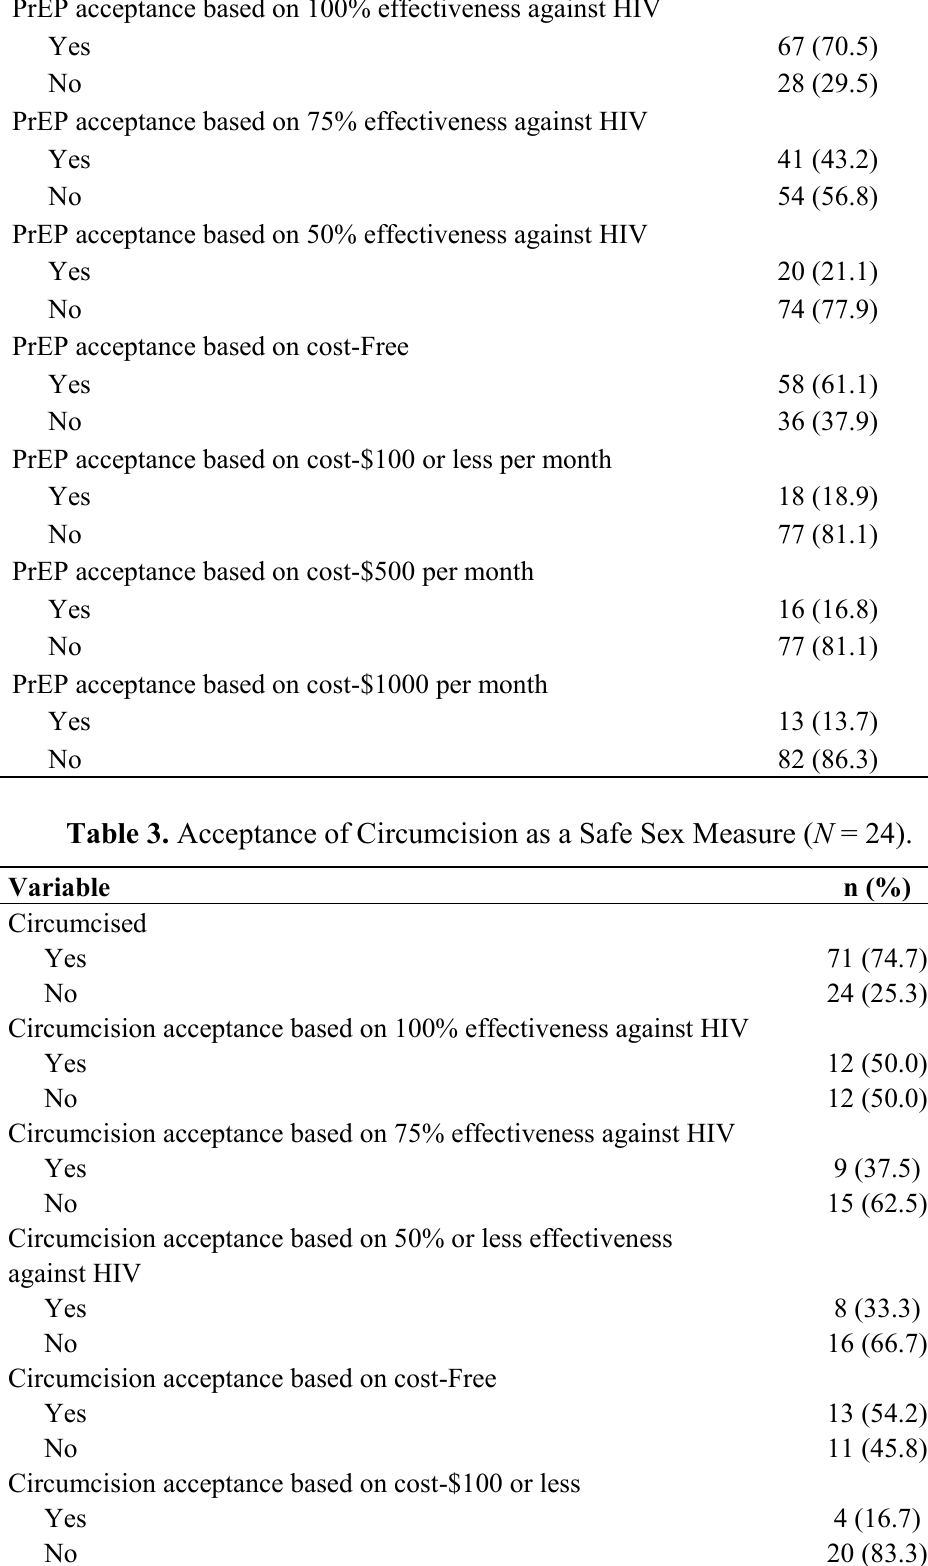
Table 2. Acceptance of pre-exposure prophylaxis (PrEP) as a Safe Sex Measure ( N = 95). Variable